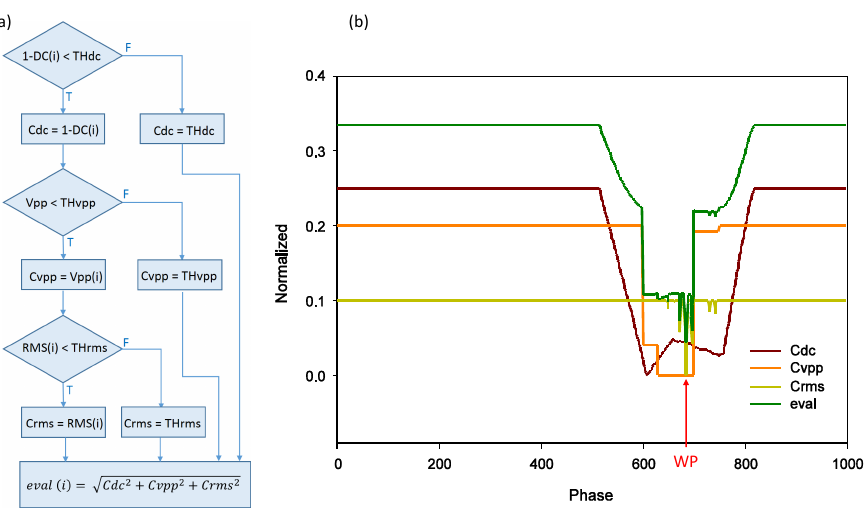
Figure 10. (a) Flow diagram calculation of the components Cdc, Cvpp and Crms from the three functions. (b) Components and quadratic sum for calculating the working point (WP) from its minimum.